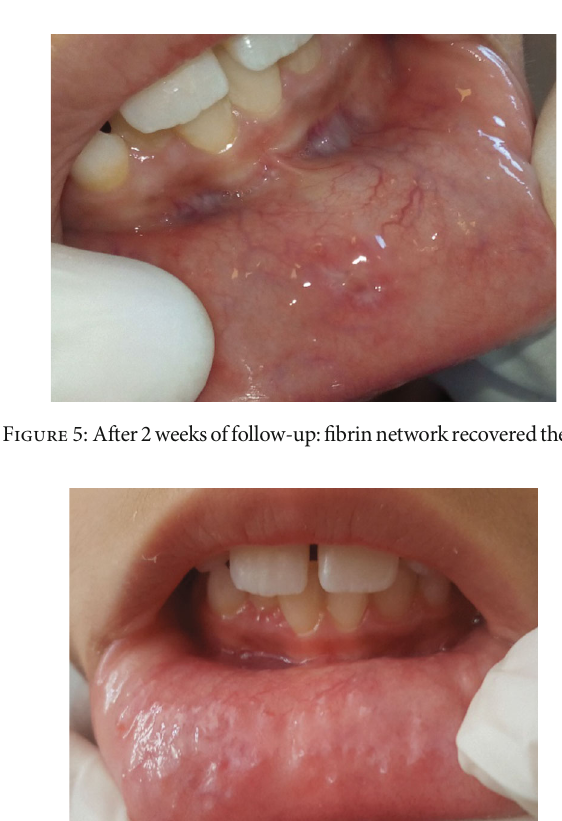
Figure 3: Immediate aspect after mucocele removal: bloodless operative site, no suture was done.